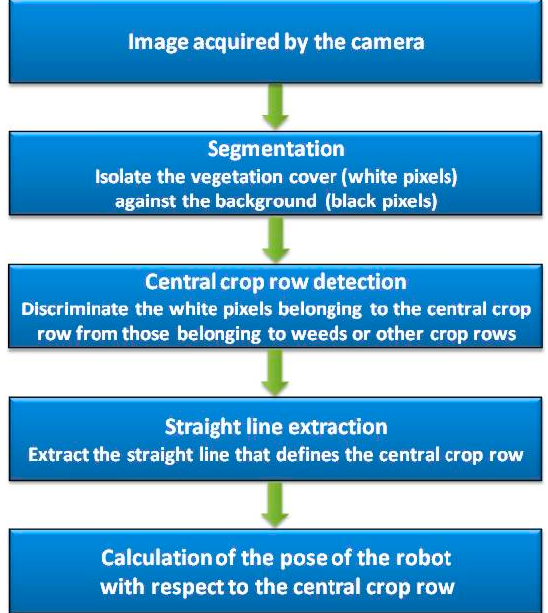
Figure 5. Diagram of the image processing phase.